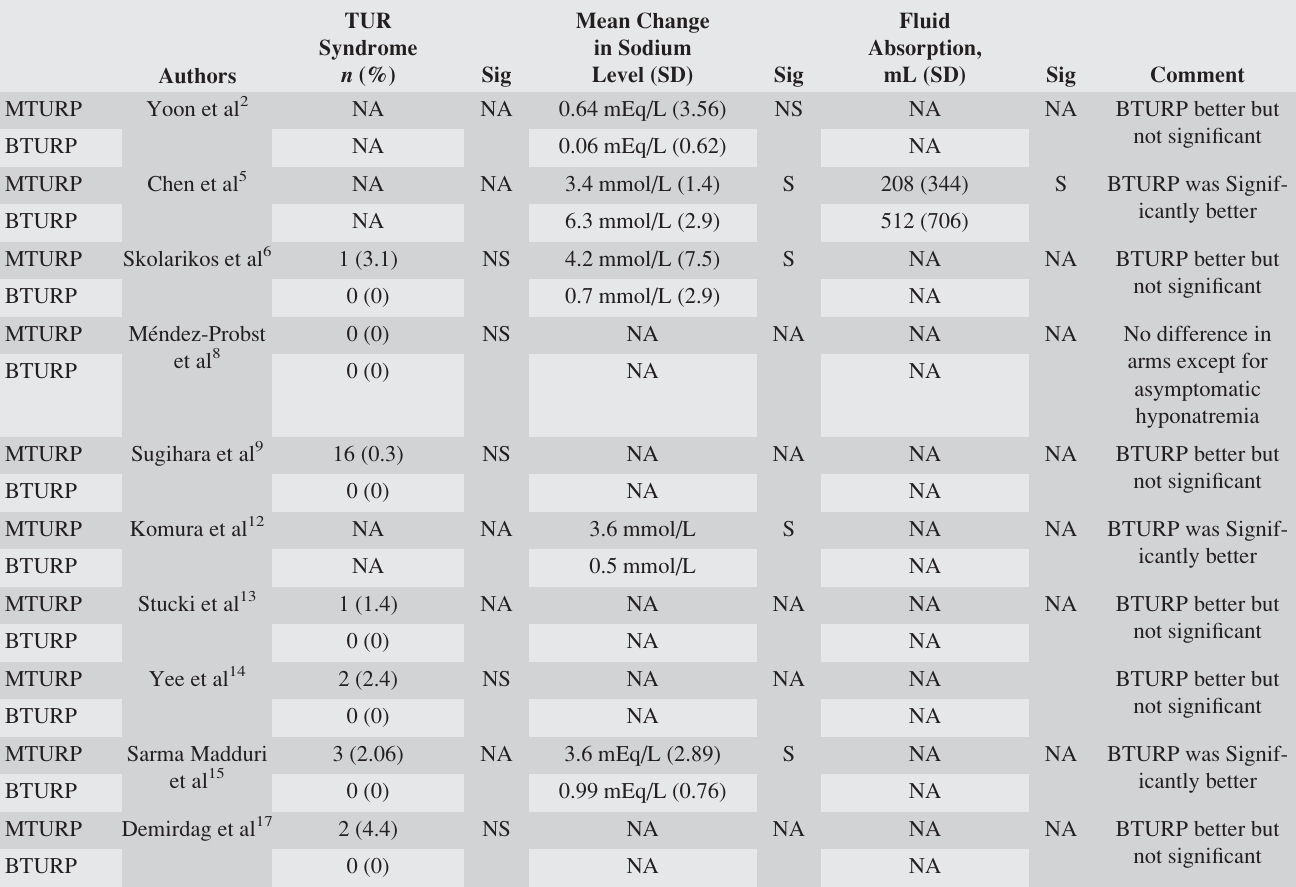
Table 3. Data From Papers Regarding the Incidence of TUR Syndrome (Serum Sodium Fall Postoperatively and Fluid Reabsorption as and Where